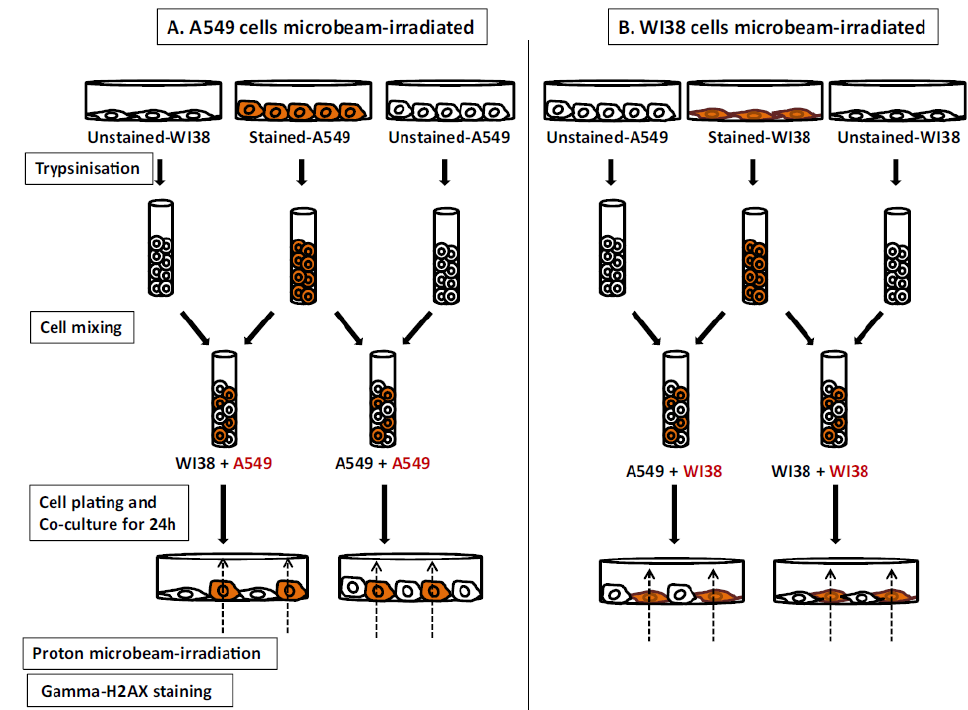
Figure 3. Experimental scheme employed in the work of Desai et al. [44]. In the beginning, the chosen targeted cells (either ( A ). A549 cells or ( B ). WI38 cells) and non-targeted cells were cultured in separate dishes. One day before the microbeam irradiation, the chosen targeted cells were labeled with cell tracker orange (CTO) in their own dishes and were then mixed with the unlabeled non-targeted cells in a 1:1 ratio to form a co-culture in the “co-culture dish” for the subsequent microbeam-proton irradiations. (Adopted from Desai et al. [44]; permission to reuse obtained from Elsevier). All the cells in the co-culture dish, regardless of whether labeled or unlabeled with CTO, were stained with Hoechst 30 min before irradiation. The nuclei of the chosen targeted cells, i.e., those labeled with CTO, were then each irradiated with 500 protons. For